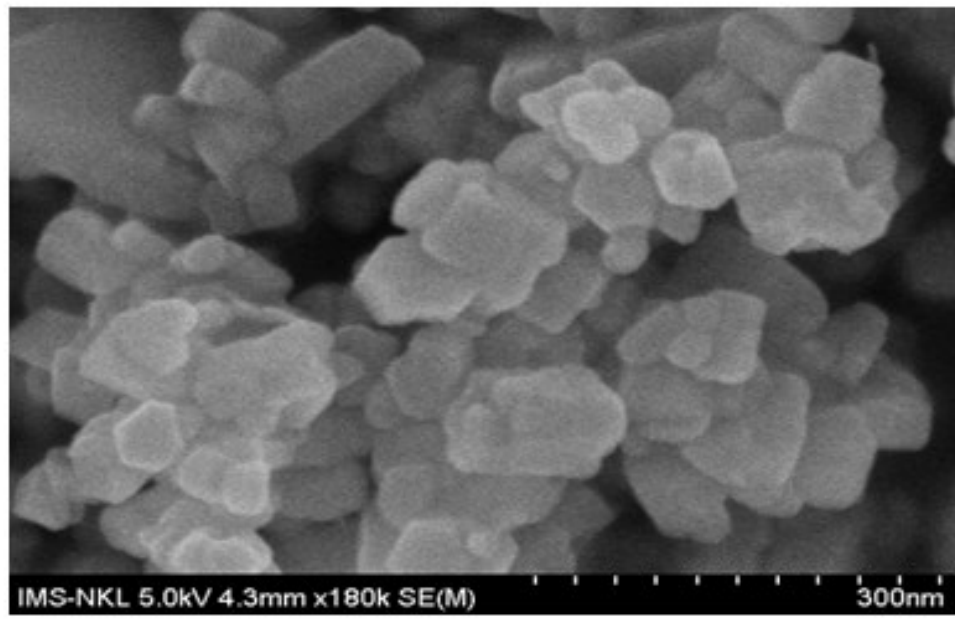
Figure 3. SEM image of ZnO nanomaterials.